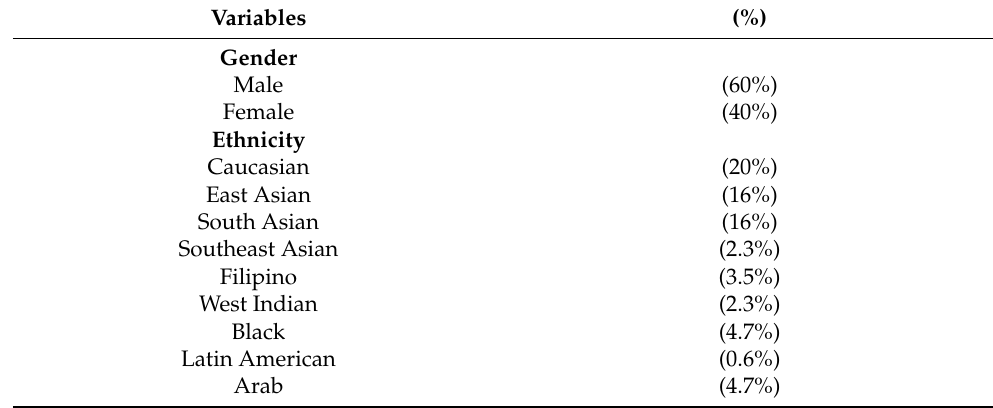
Table 1. Demographic characteristics and impacts of COVID-19 for participants ( n =